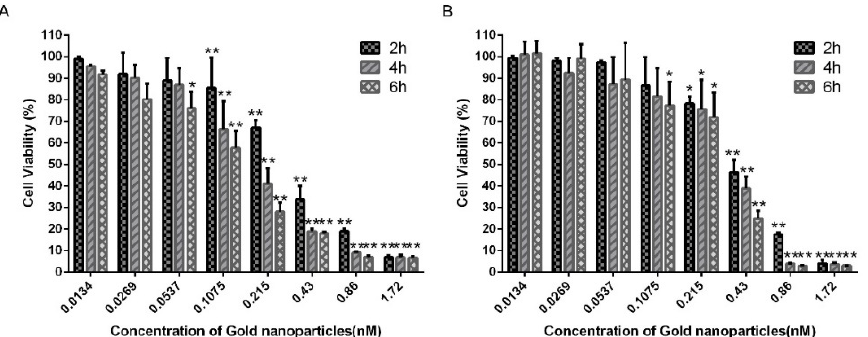
Figure 3. The dark cytotoxicity of PEG-AuS. Notes: ( A ) The cytotoxicity of PEG-AuS on SGC-7901 cells. ( B ) The cytotoxicity of PEG-AuS on GES-1 cells. *: p < 0.05; **: p < 0.01.